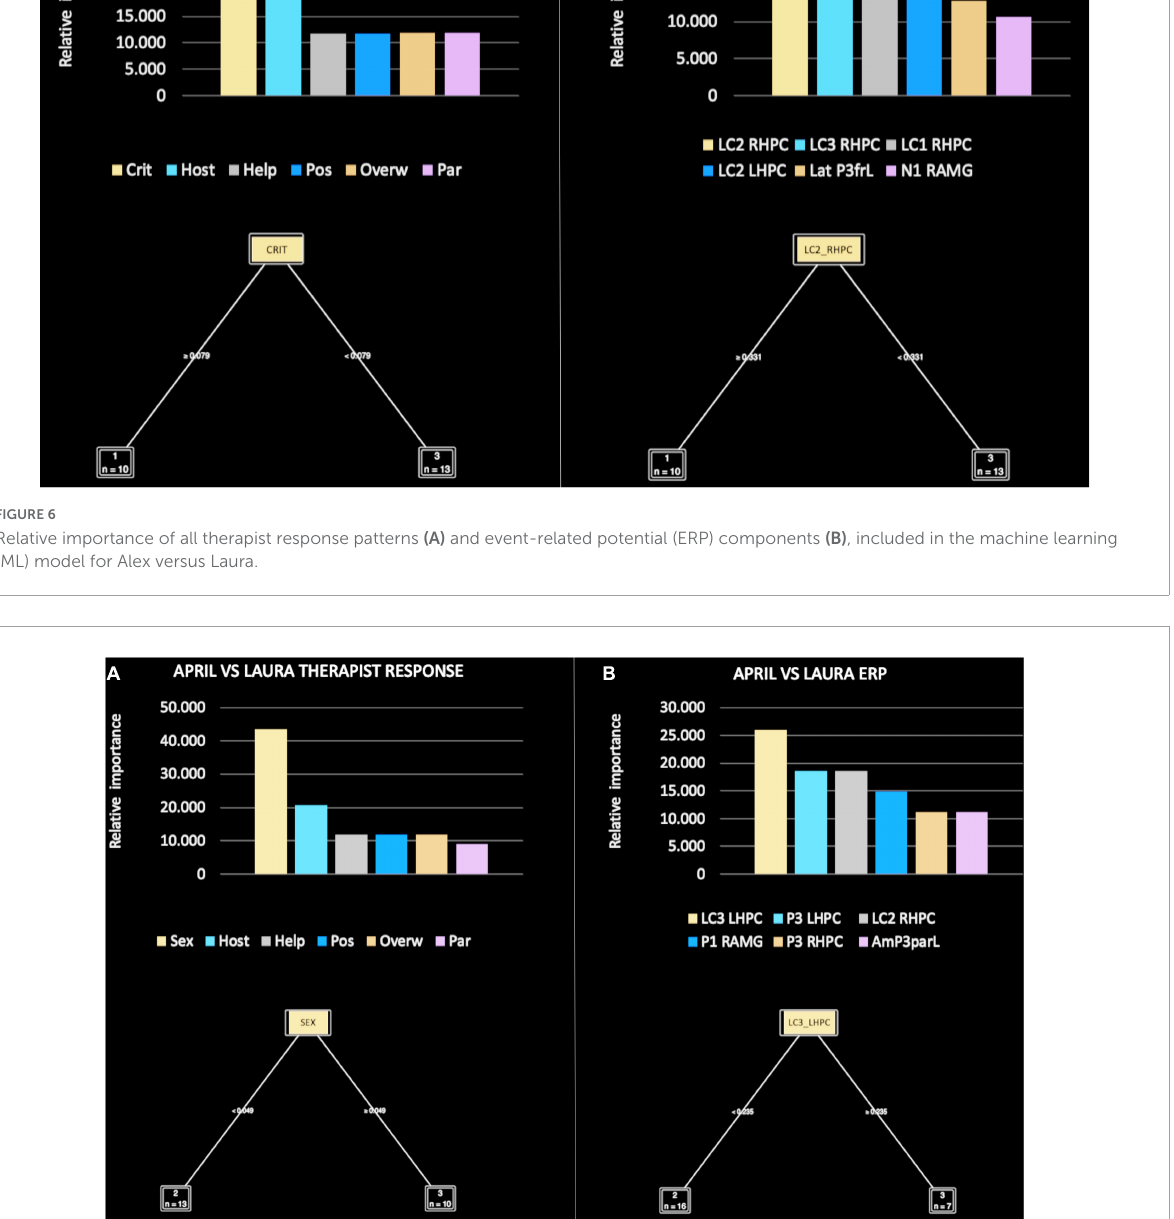
The relative importance of ERP components was, in order: LC3 LHPC (25.926), P3 LHPC (18.519), LC2 RHPC (18.519), P1 RAMG (14.815), P3 RHPC (11.111), and AmP3 parL (11.111)